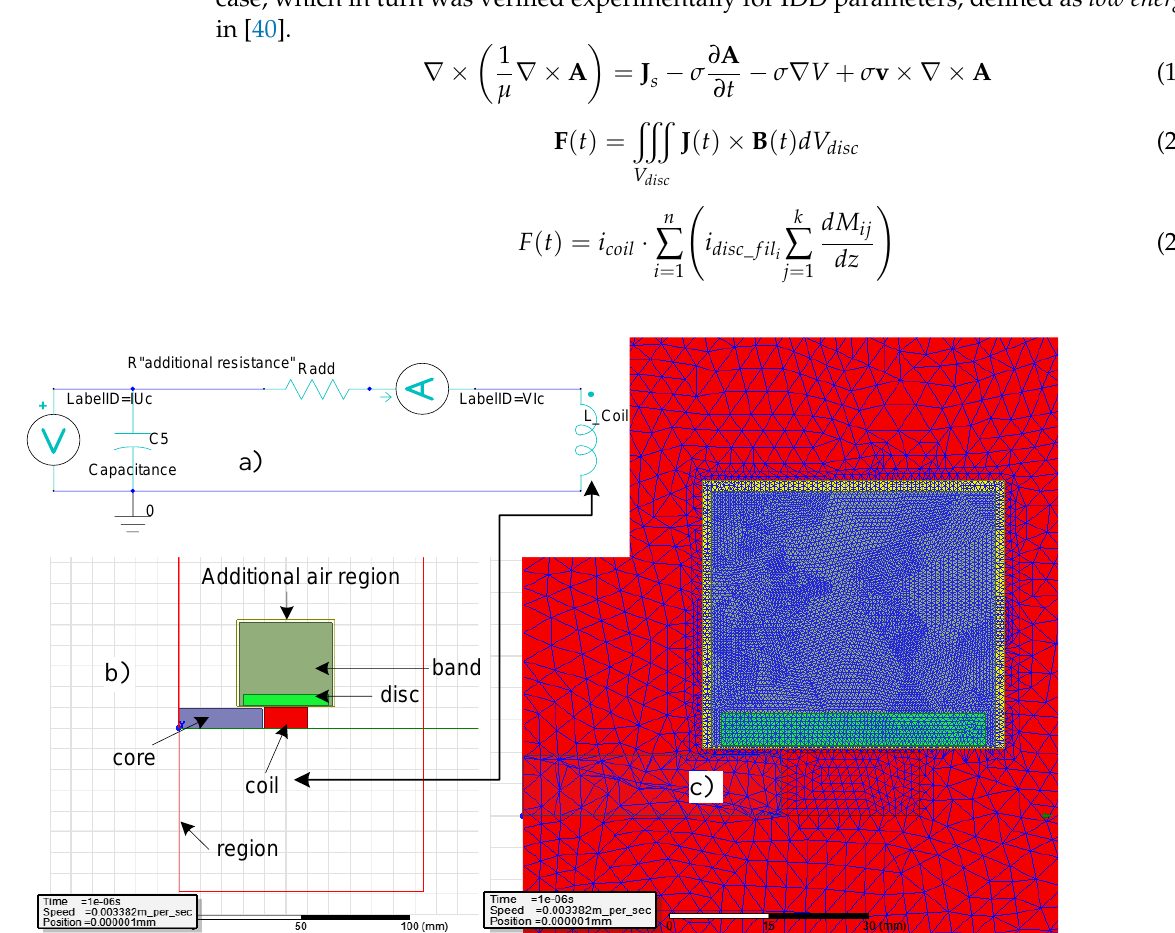
Figure 11. Maxwell EL model: ( a ) Thomson coil power circuit, ( b ) IDD objects, ( c ) discretization of objects.